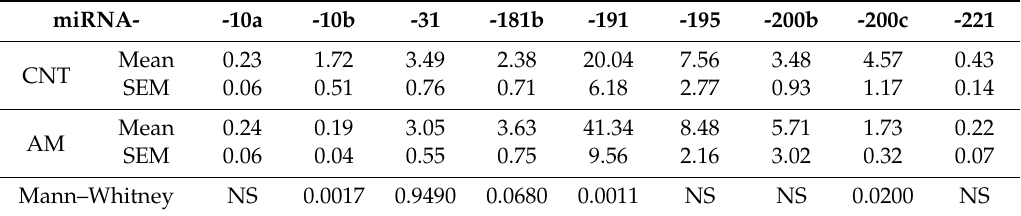
Table 3. Results of the comparison of selected miRNAs expression in groups of samples. miRNA-